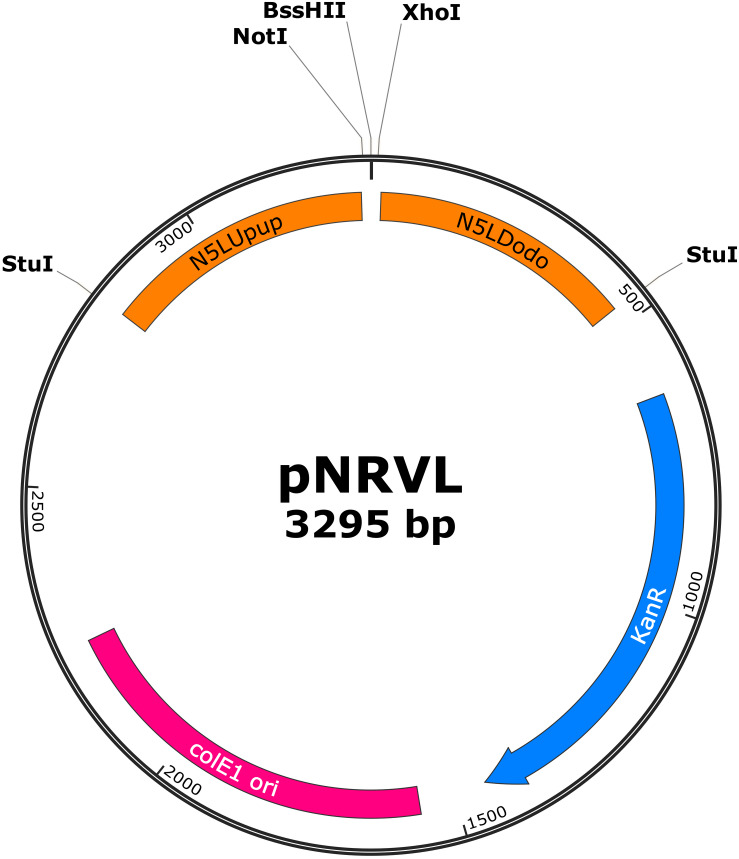
Map of pNRVL, a vector encoding a replacement cassette targeting CpN5LUpup and CpN5LDodo. Selection markers and gene of interest can be cloned between NotI/BssHII and BssHII/XhoI, respectively. Replacement cassette can be released by StuI digestion.